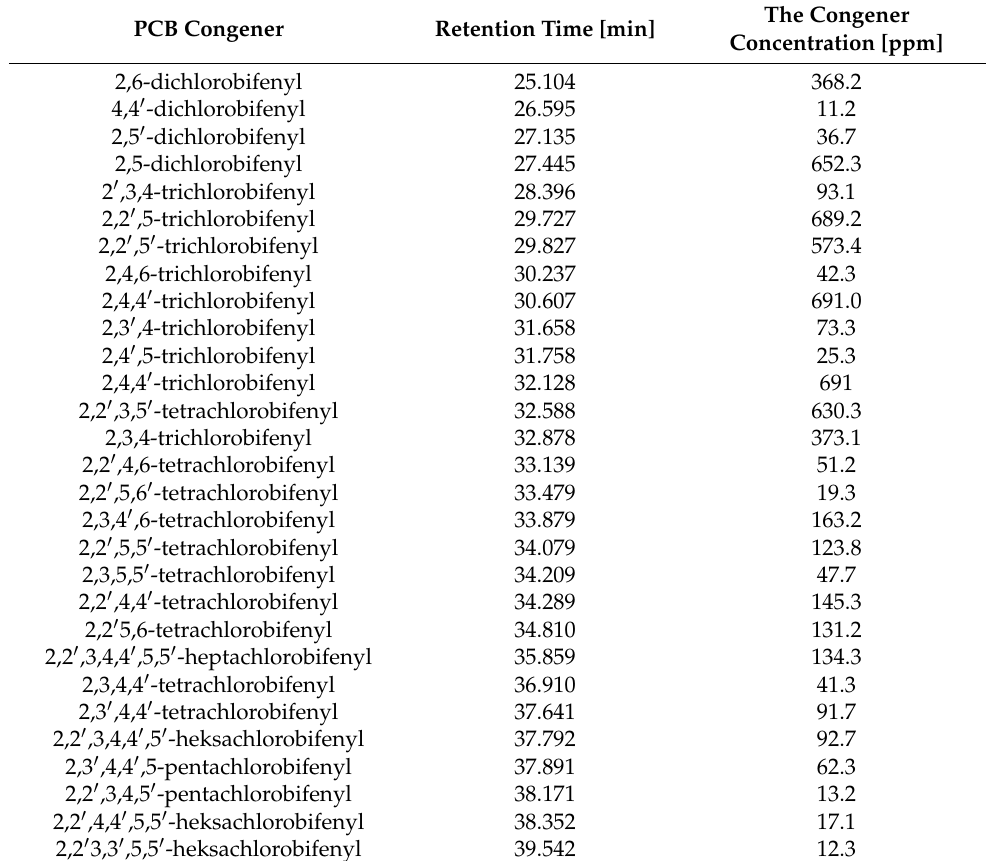
Table 2. Table 1. The PCB congeners concentrations in transformer oil.